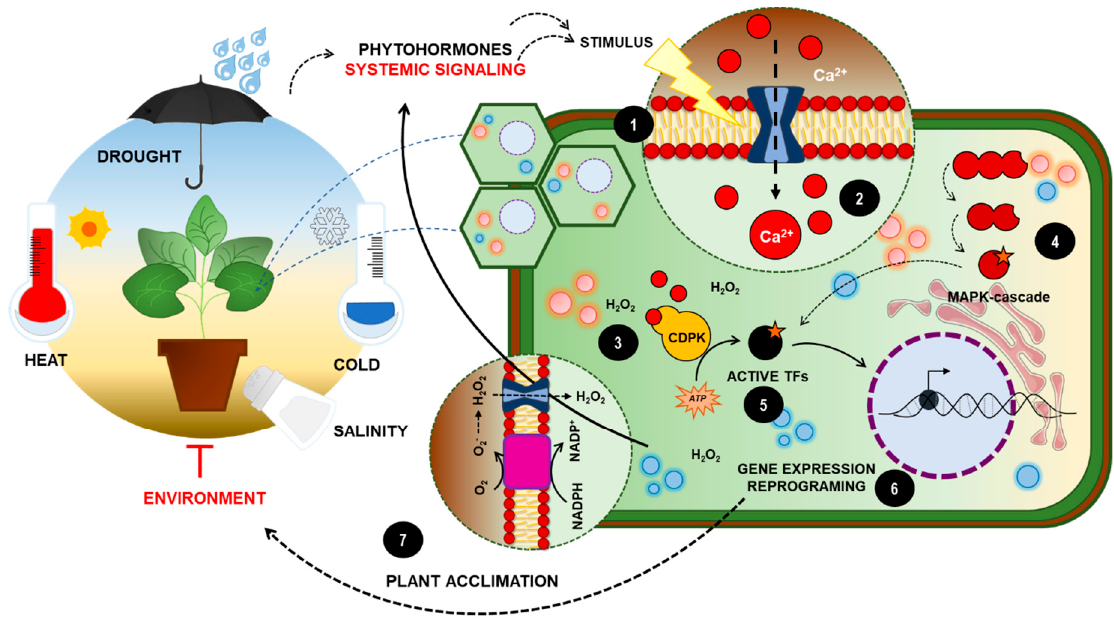
Figure 2. General sensing mechanisms for abiotic stresses. Most of the mechanisms for sensing and triggering adaptive responses to multiple abiotic stresses are associated with changes in proteins and lipids in biological membranes (1). Adverse conditions impose ultrastructural changes in biomolecules, which are sensed by receptors or specialized proteins, converging, typically, to Ca 2+ accumulation in cytosol (2), as well as REDOX imbalances (3). These signals activate kinase cascades and other secondary events that stimulate phosphorylation/dephosphorylation cascades (4), culminating on TFs activation (5) and gene expression remodeling (6). Several enzymes involved in the biosynthesis of osmolytes, pigments, thermoprotectants and other secondary metabolites are also activated, in addition to ROS detoxifying enzymes, which attempt to reestablish redox homeostasis in cells subjected to stress (7). At the systemic level, morphological changes are detected in the root and leaves, such as the proliferation of lateral roots in response to drought, and biochemical changes, such as the secretion of phytochelants in response to heavy metals, as well as stomatal reclusion and closure, in addition to reduction of leaf area and abscission. If acclimation response mechanisms are not efficient enough to restore plant homeostasis, cells trigger early senescence, redirecting nutrient flow to reproductive tissues and seed generation through their stress-triggered cell death programs.